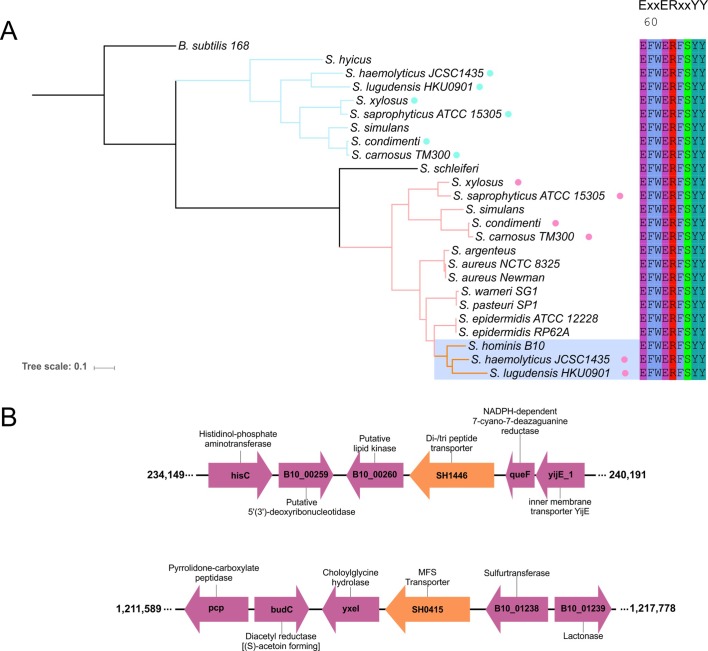
Phylogenetic relationship of staphylococcal SH1446 orthologues.(A) Genomic context of the S. hominis transporter genes SH1446 and SH0415 in S. hominis SK119. (B) Phylogenetic tree of staphylococci POT transporters. The tree was built using maximum likelihood with best-fit evolutionary model automatically inferred by IQ-TREE v1.5.5 (Trifinopoulos et 632 al., 2015). Blue highlighted subclade denotes malodour producing staphylococci and coloured circle represents presence of two POT’s in the same species.